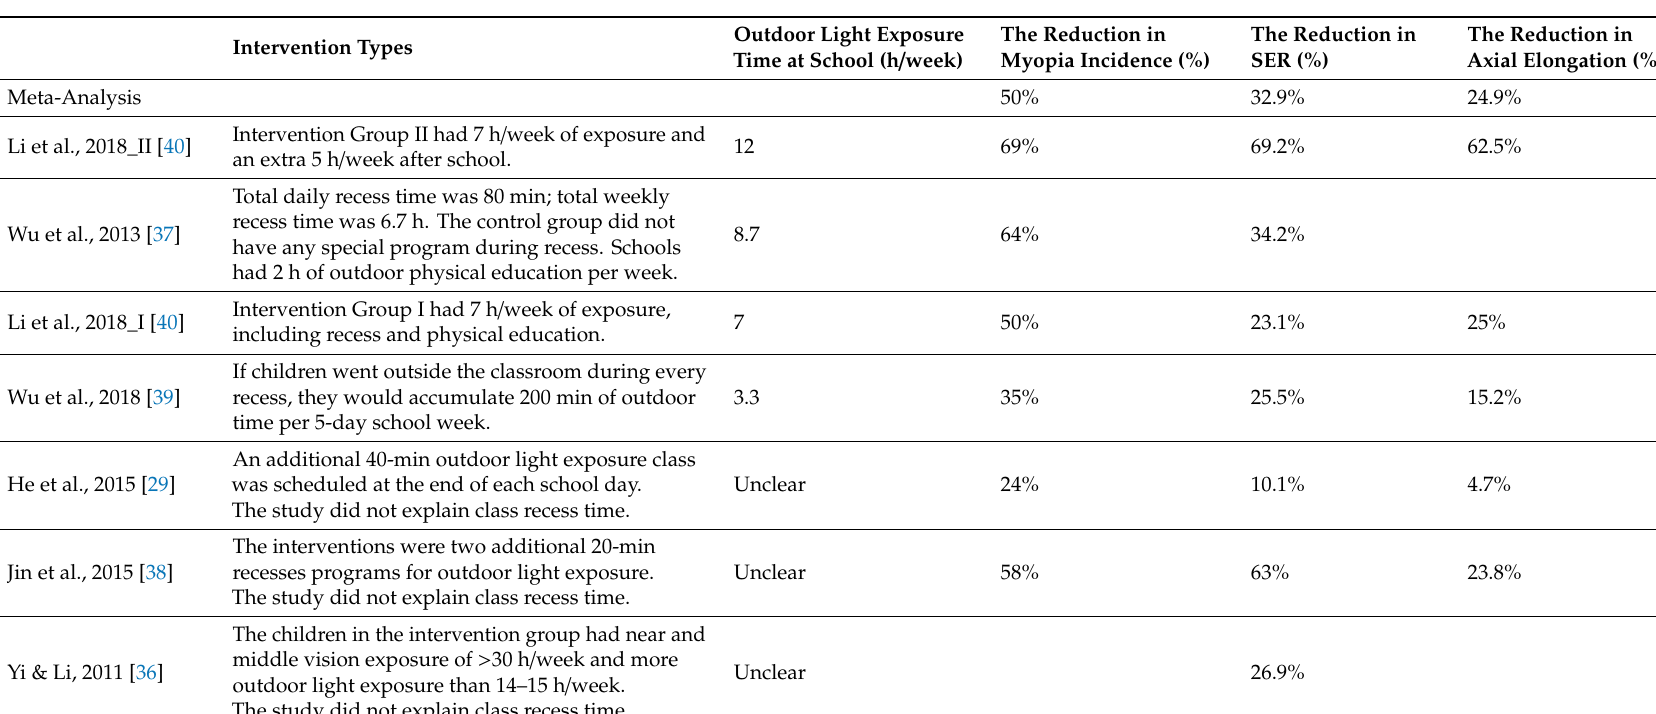
Outdoor Light Exposure The Reduction in The Reduction in The Reduction in Time at School (h / week) Myopia Incidence (%) SER (%) Axial Elongation (%)